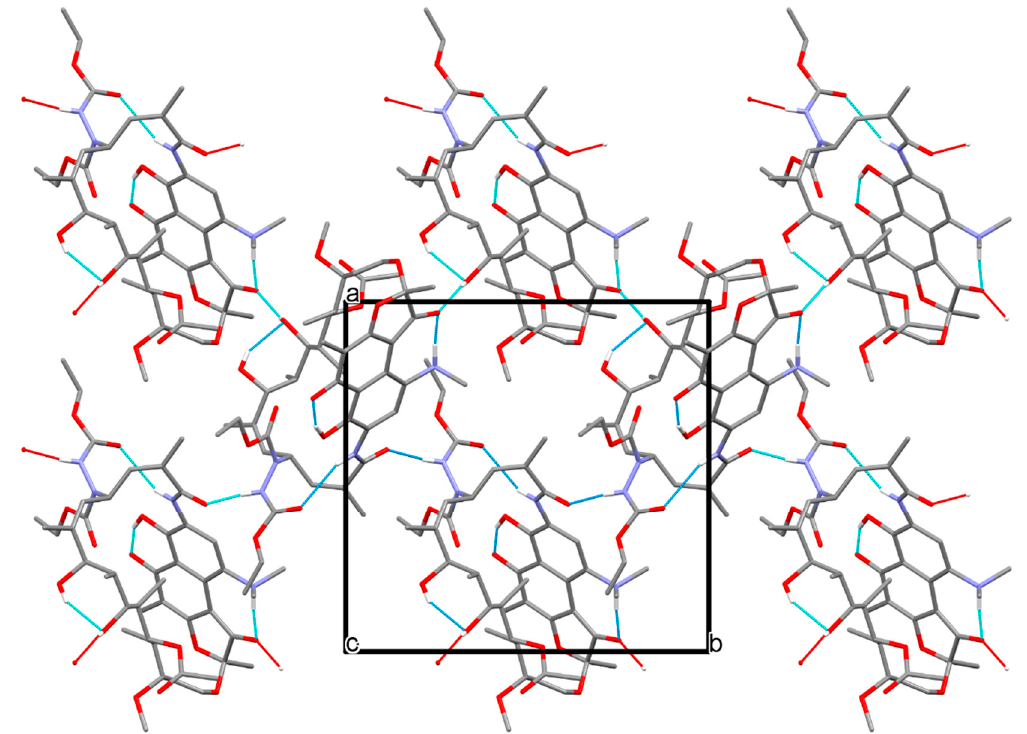
Figure 3. A view of part of the crystal packing of compound 3 , showing the formation of a layer of two crosslinked infinite chains parallel to the b -axis of the unit cell. Inter- and intramolecular hydrogen bond interactions are shown as dark and light blue dashed lines, respectively. Incomplete hydrogen bonds are shown as red dashed lines. Table 2. Selected torsion angles (°) and intramolecular contact distances (Å) for compound 3 and related structures *.